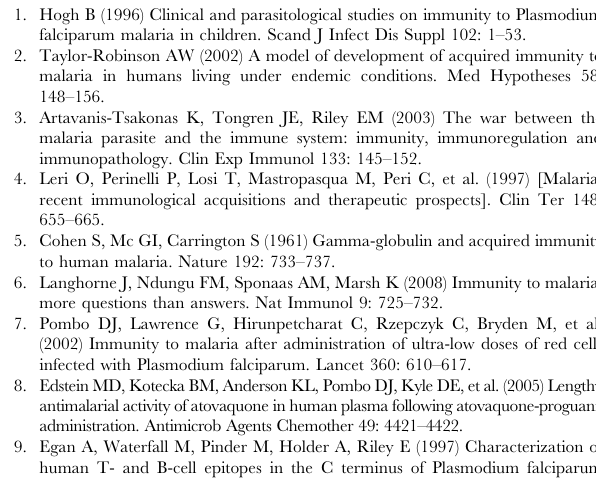
Figure S1 Representative forward versus side scatter gating strategy for peripheral blood mononuclear cells from adult Kenyan study participant (panel A) examined for IFN- c expression by CD4 + T cells incubated ex vivo for 7 days with culture medium with PBS (panel B) or recombinant MSP1 42 -3D7 (panel C) by FlowJo Software. Similar analyses were done in parallel for CD8 + T cells. Figure S2 Schematic representation from one individu- al showing the proportion of each T-cell subset based on the expression of the cell surface markers CD45RA and CD62L determined after gating for MSP1-specific IFN- c expression by CD4 + T cells. Similar studies were done in parallel for CD8 + T cells.